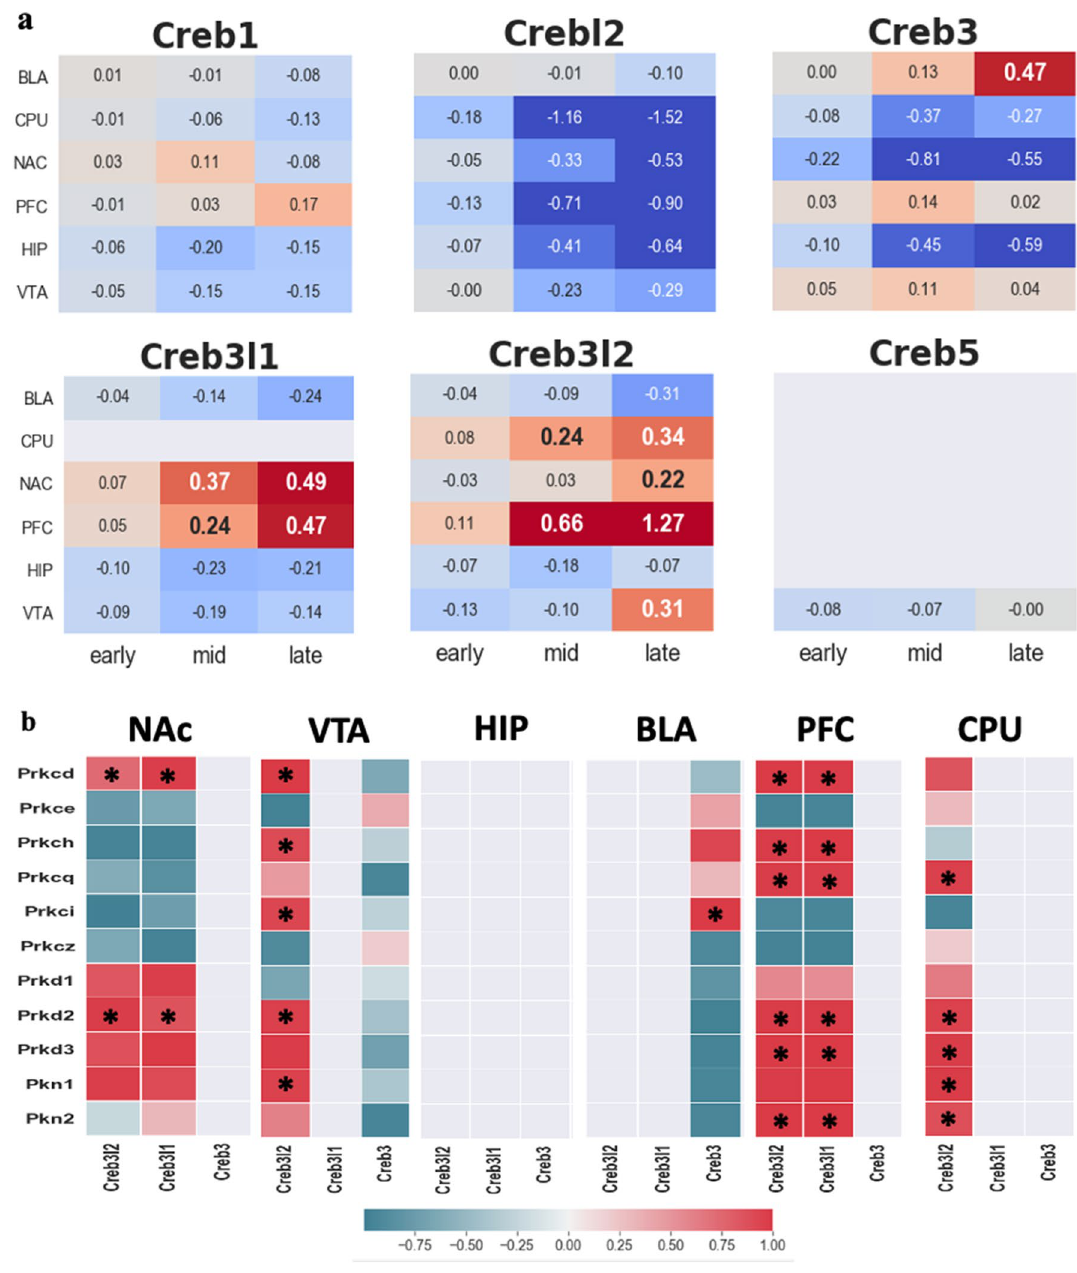
Figure 4. Log2FC trend for cAMP response element-binding protein ( Creb ) family and their coregulation with Pkc family. ( a ) Among Creb family, three of OASIS family shows upregulation pattern of Log2FC trend; Creb3 increases significantly from late stage of BLA, Creb3l1 shows upregulation from mid stage of NAC and the PFC and upregulation of Creb3l2 occurs from mid stage of CPU and the PFC and late stage of NAC and VTA, respectively. ( b ) Coregulation between Pkc family and OASIS family. Colored rectangles indicate only upregulation gene. Asterisk *indicates differentially expressed genes (Log2FC > 0.2) on both rows and columns. Reddish color indicates positive correlation between the genes. Teal color indicates negative